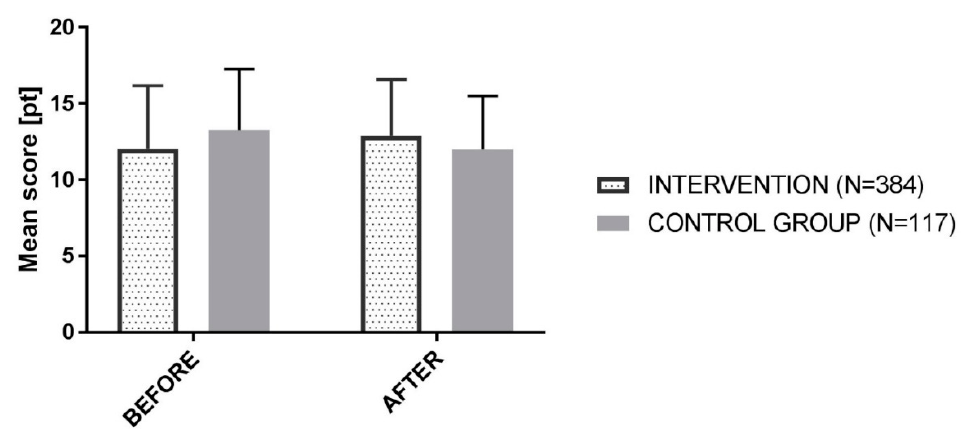
Figure 2. Summary of mean results gained in questionnaires before and after